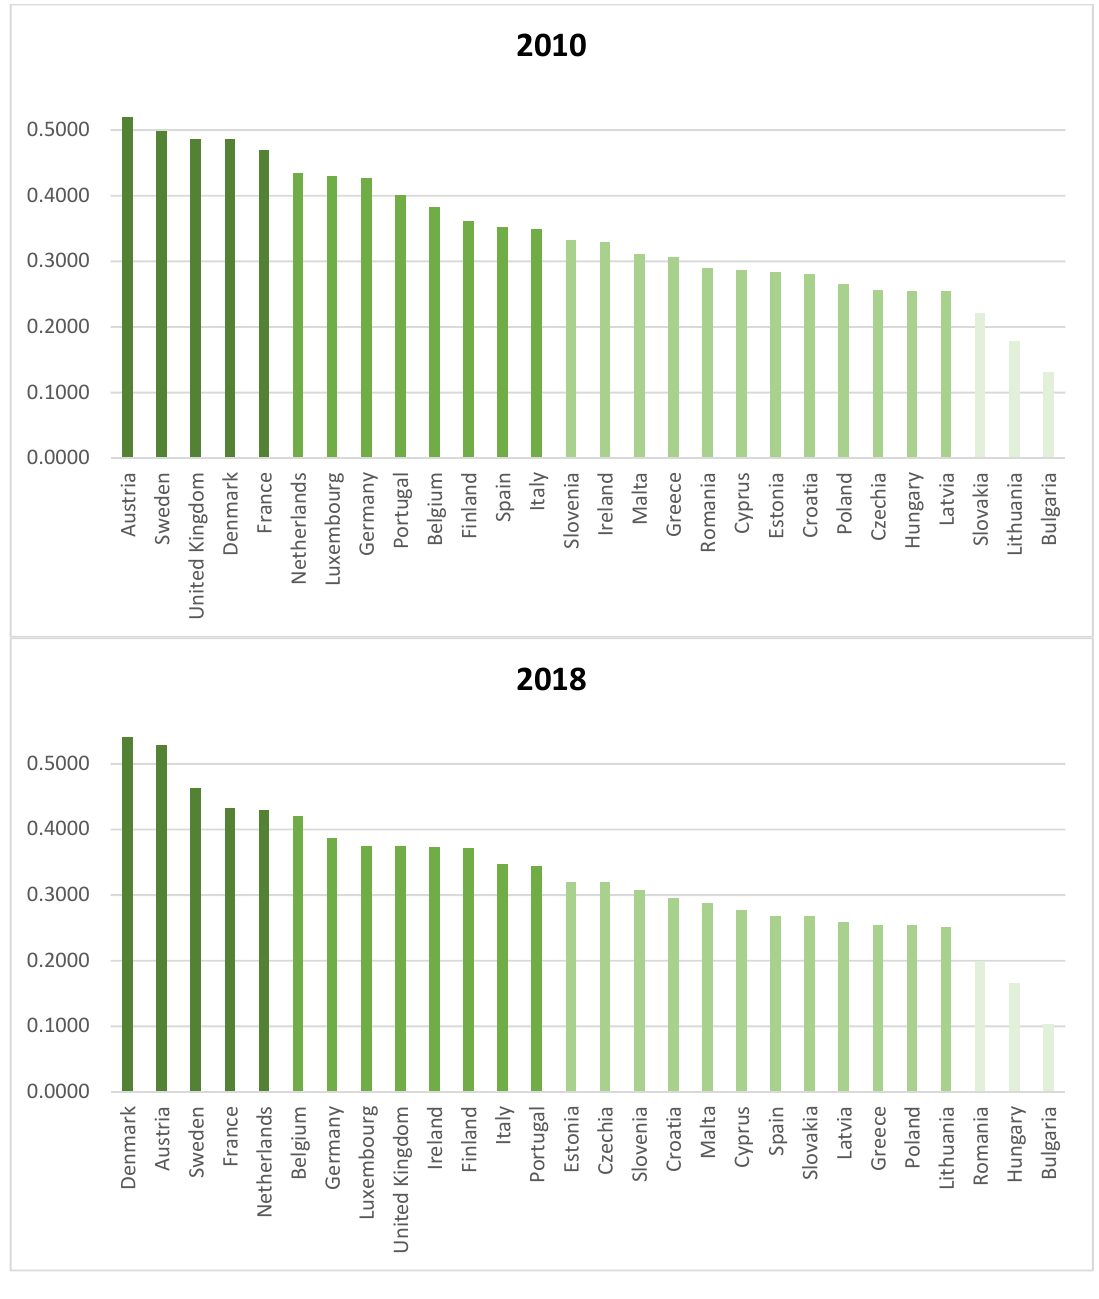
Figure 1. EU countries ranking based on GEI in 2010 and 2018. Source: own calculation. The average GEI in 2018 for all the analysed countries was 0.3294, and in the base year it was 0.3423, which meant that in the analysed years the general level of ‘greening’ (Table 2). The Czech Republic noted the highest advance in the ranking (+8 places) of the economies in EU member states decreased. It should be emphasised that this level was very low considering the possible range of GEI (0.1). Standard deviations of the indi- of ‘green’ transition processes in respective countries.